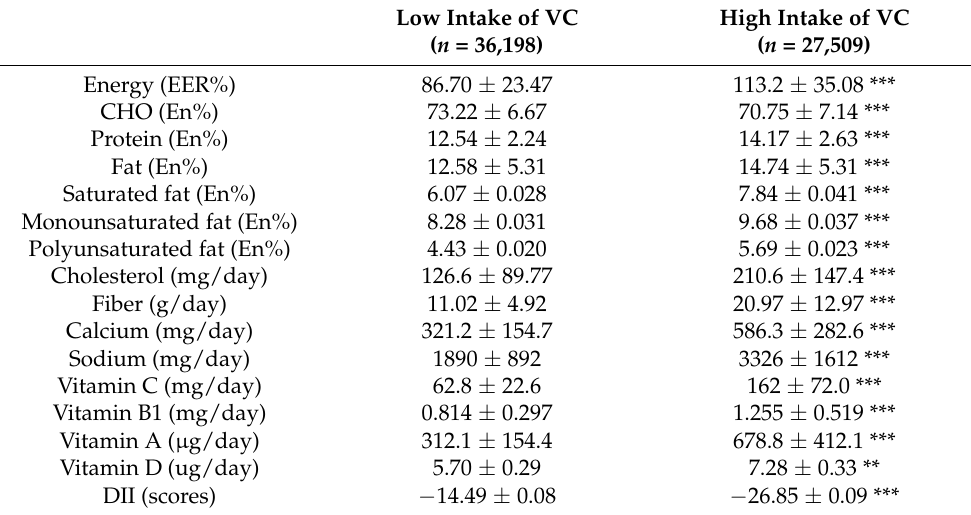
Table 2. Energy and nutrient intake and dietary inflammation index (DII) according to dietary vitamin C (VC) intake